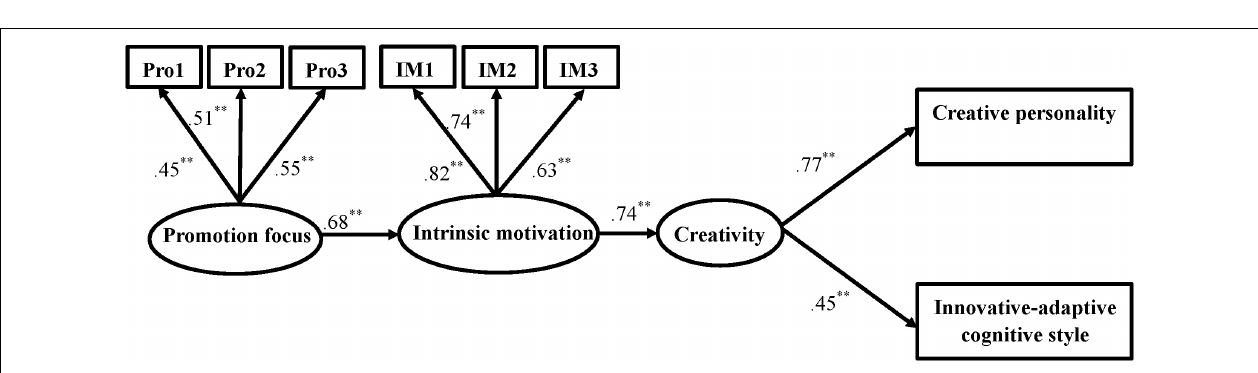
FIGURE 2 | The hypothesized model of regulatory focus, motivation, and creativity with path coefficients. * *p < 0.01; (cid:57)(cid:57)(cid:75) : indicates path that was hypothesized but not significant.